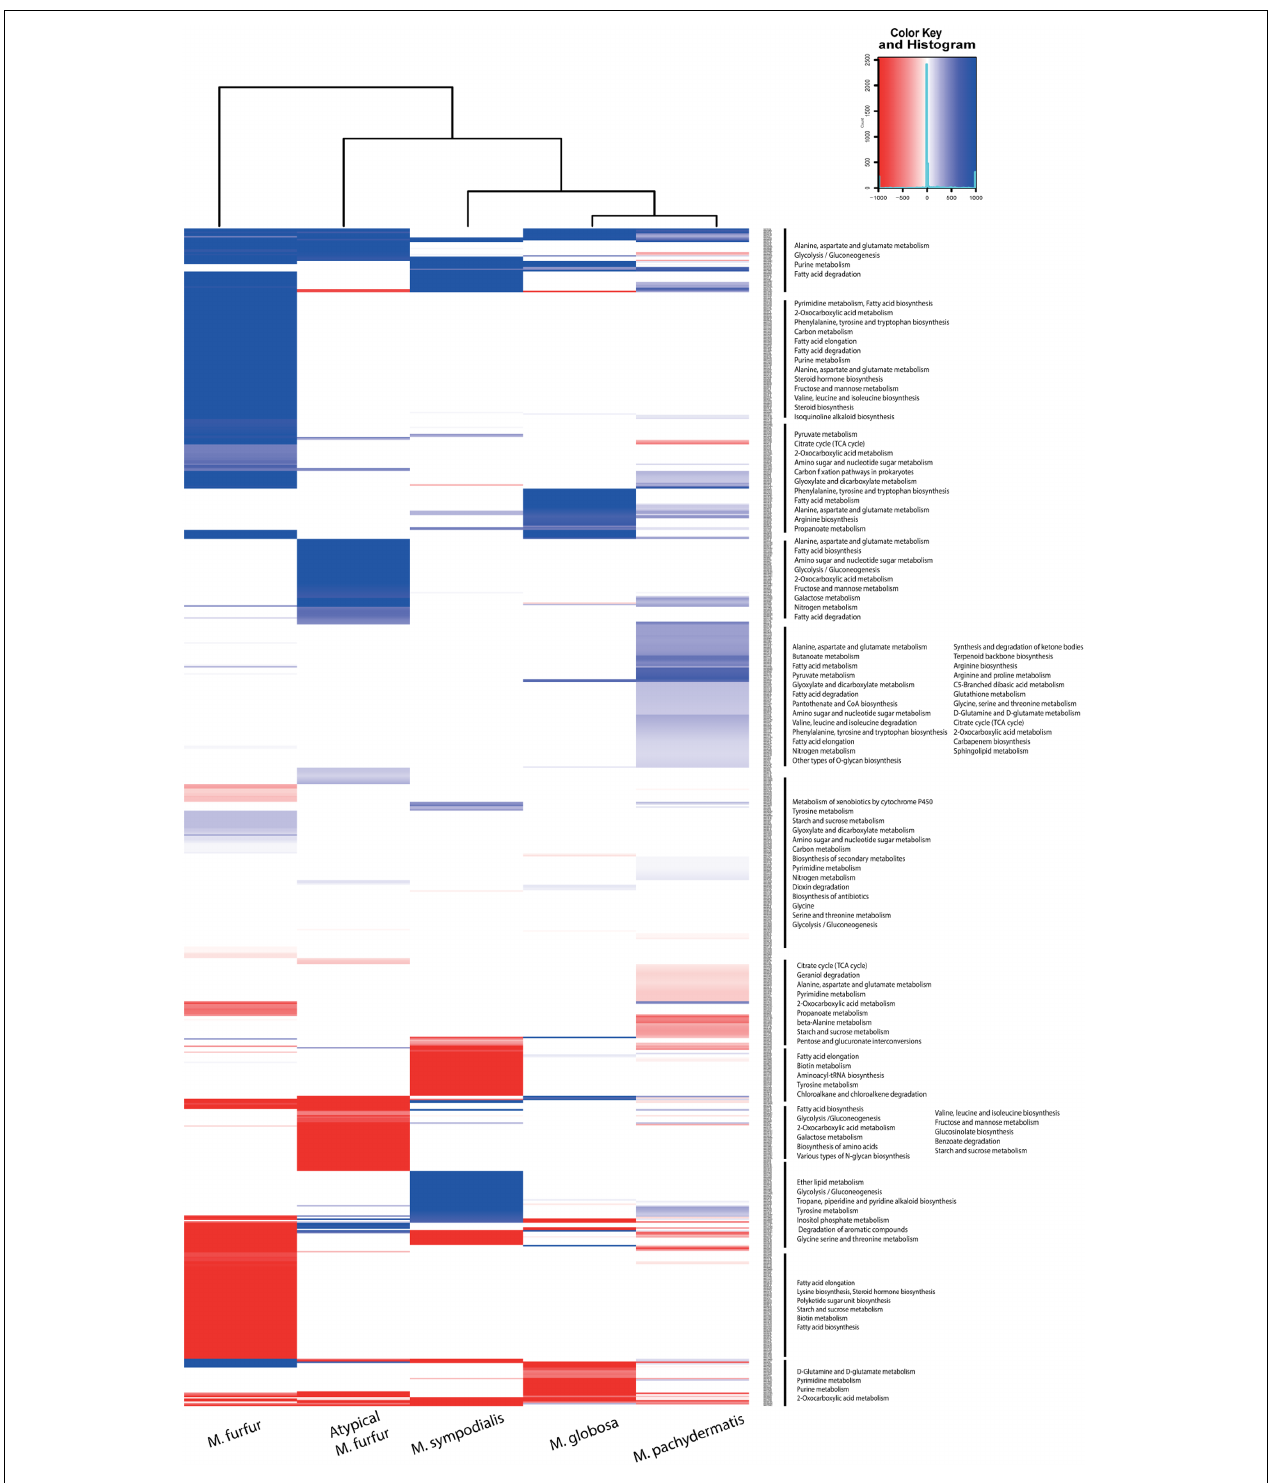
FIGURE 7 | Flux distribution resulting from the flux balance analysis (FBA) of each metabolic network reaction filtered for visualization with a cutoff of ± 0.05 mmol gDW - 1 h - 1 .